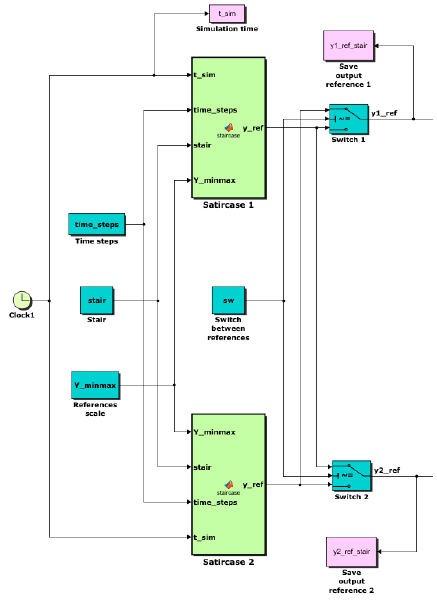
Figure 12. Staircase type inputs.